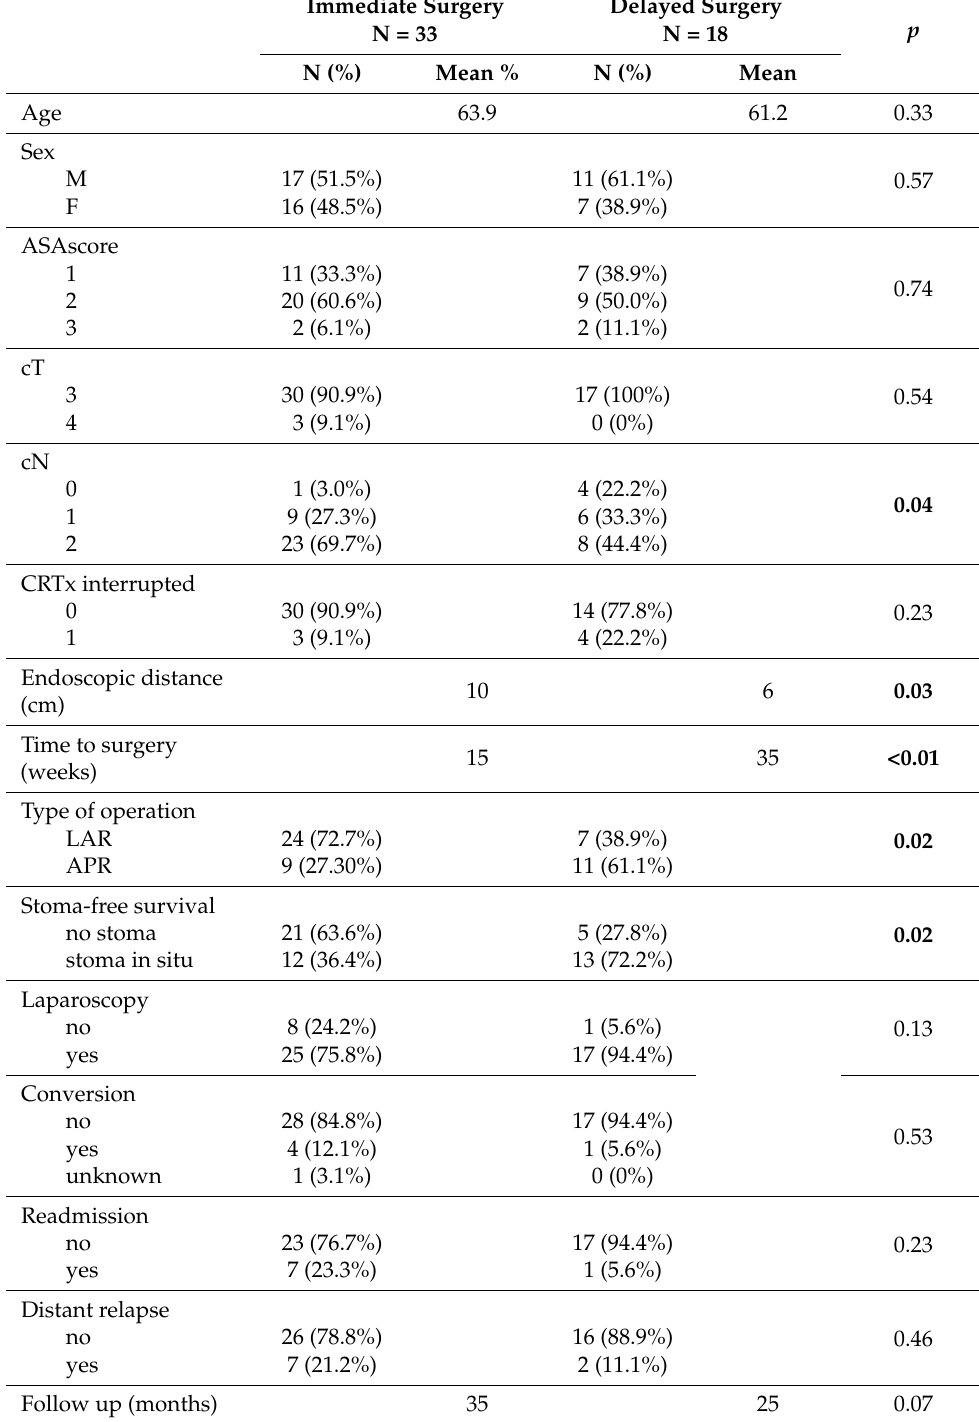
Table 1. Patientdemographicsimmediatevs. delayedsurgerygroups. p